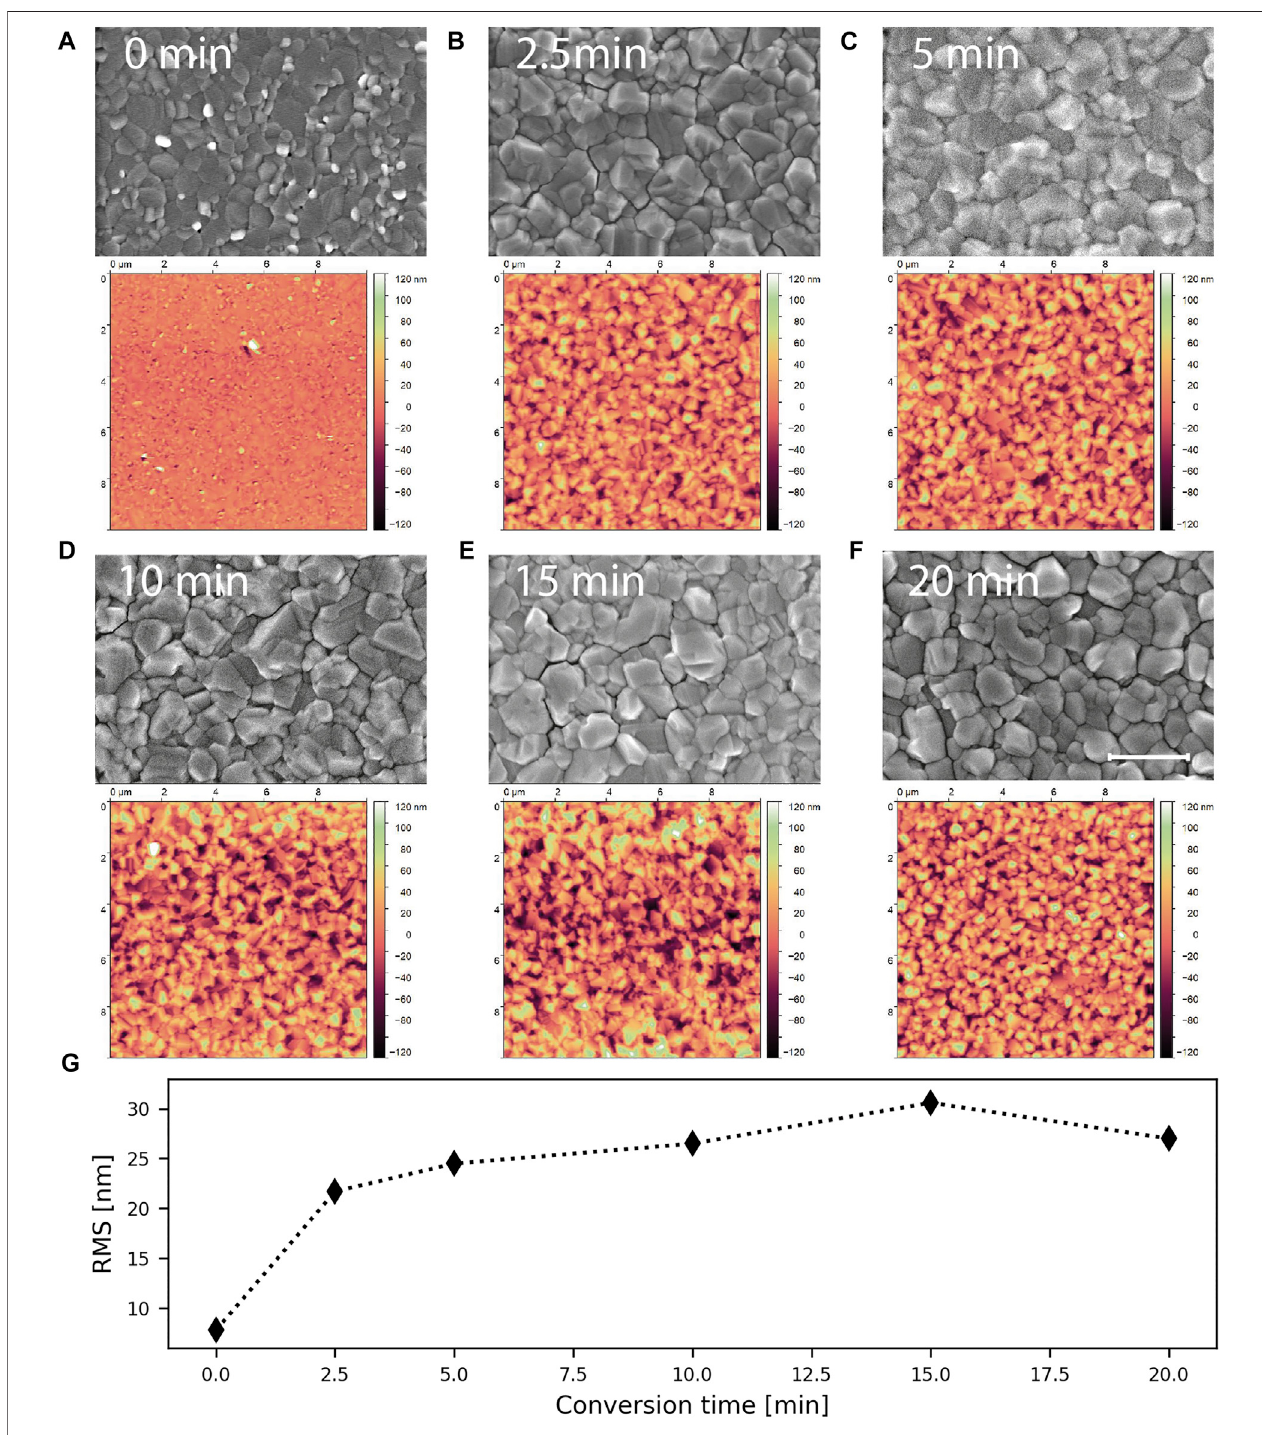
FIGURE3| Evolutionofthetop morphologyduring CVD.AFM scanand SEM topview image ofthesample after (A) 0, (B) 2.5, (C) 5, (D) 10, (E) 15and (F) 20 min of CVD. The scale bar corresponds to 1 μ m and applies to all SEM images. (G) RMS roughness extracted from the AFM scans shown in (A – F) .